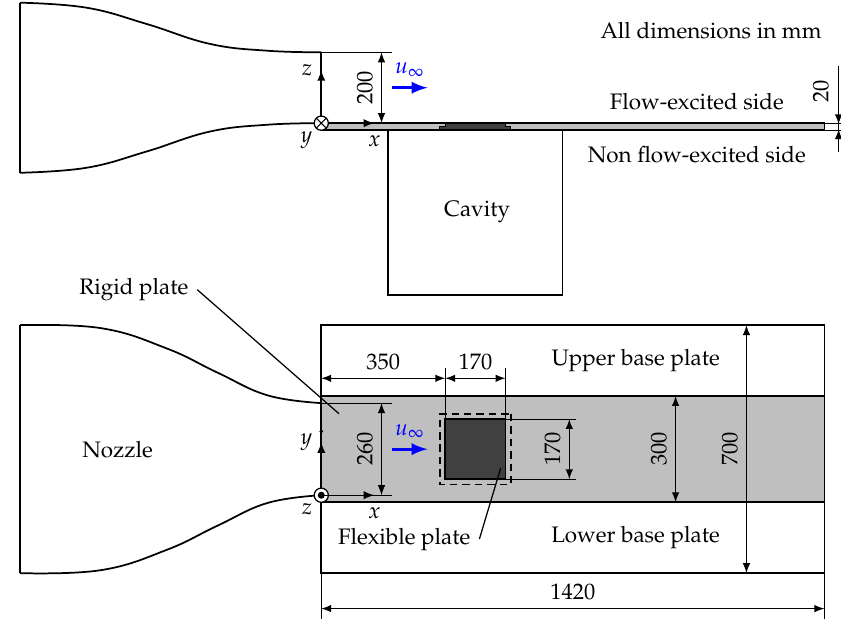
Figure 2. Schematic sketch of the experimental